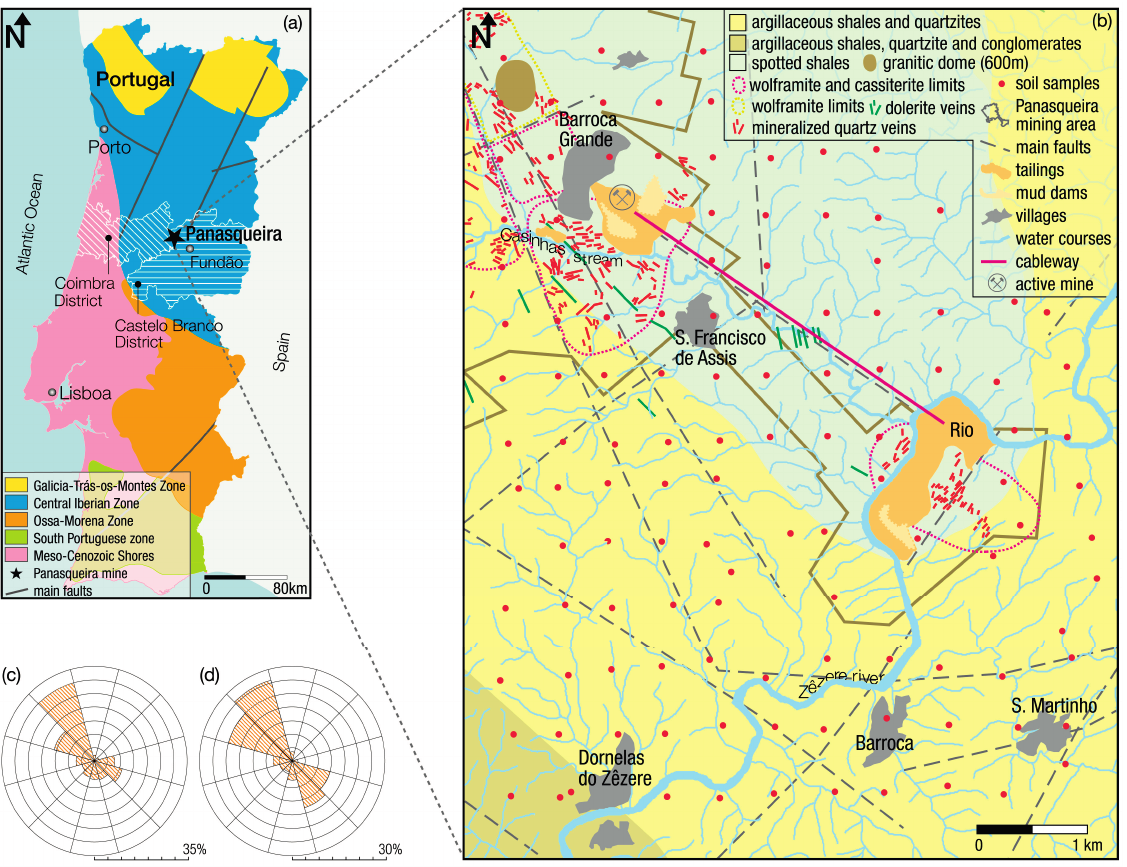
Figure 1. ( a ) Synthetic map of Portugal showing the location of Panasqueira mining area; ( b ) details of the study area, main geological units and soil samples grid - geological map adapted from [34,41,45]; ( c ) wind rose of the prevailing winds on the top of the mine (Barroca Grande tailing); and ( d ) on the top of a mountain 800 m north of the mine